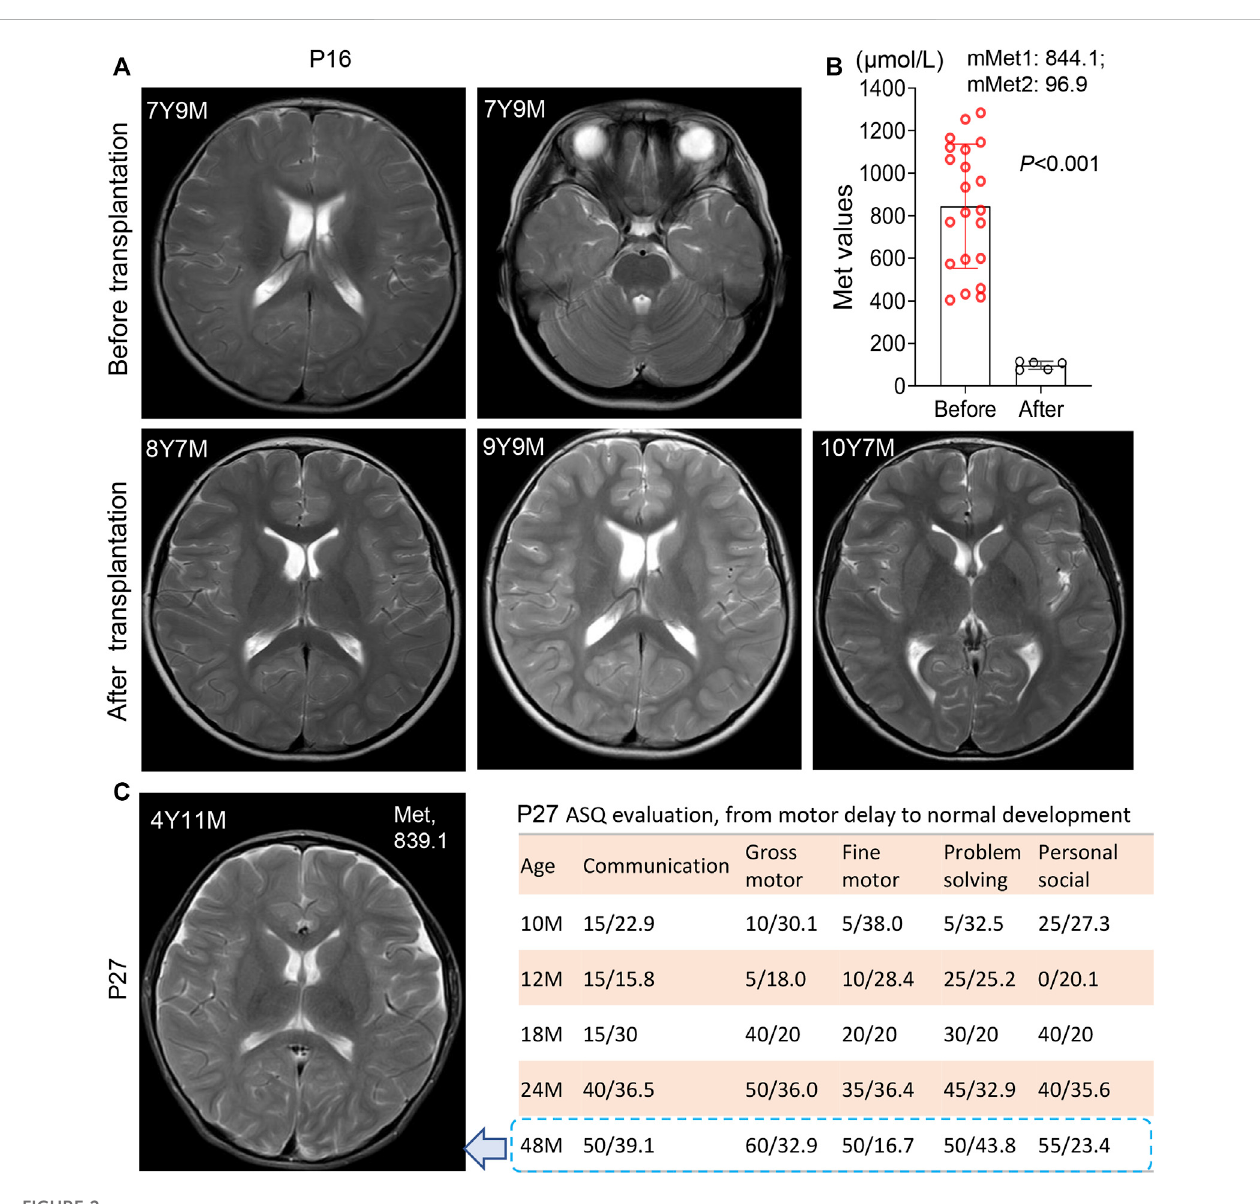
FIGURE 2 White matter lesions and development status in patient 16 and patient 27. (A) Brain MRI scanning before and after liver transplantation in patient 16 at different time points. 7Y9M = patient at 7 years-9 months old. Patient 16 harbored a heterozygosis c.695 C > T/p. P232L. White matter lesions was reversed after liver transplantation. (B) Signi fi cant decrease of Met levels after transplantation in patient 16, from 844.1 μ mol/L (before) to 96.9 µmol/L (after). mMet1: 844.1 = mean Met value before transplantation was 844.1 μ mol/L; mMet2:96.9 = mean Met value after transplantation was 96.9 μ mol/L (C) Brain MRI scanning of patient 27 at the age of 4 years 11 m with anomalies in white matter. The plasma Met concentration was maintained at 839.1 μ mol/L left panel display hisdevelopment status measuredby ASQ (Ages-Stages Questionnaire).P27 had anormal development after SAMe supplementation. *, p < .05; **, p < .01; ***, p <